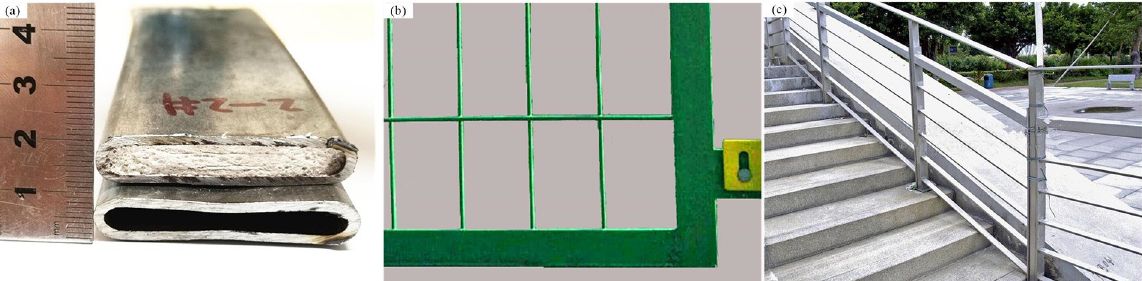
Fig 1. Products in which CORFTs are used. (a) Core filled tube and tube, (b) fences, and (c) stair